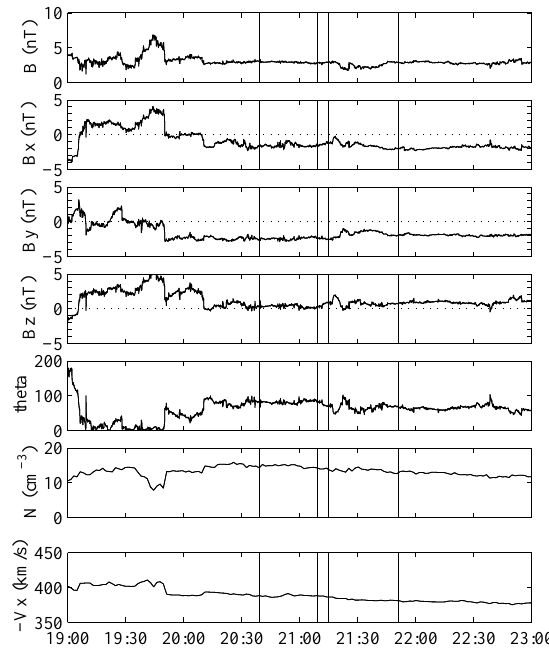
Fig. 4. Unshifted solar wind data in GSE-coordinates from WIND MFI (time resolution 3s) and SWE (time resolution 92s). The ver- tical lines show the times of the substorm onset and subsequent in- tensifications as determined from ground-based magnetic field data. The propagation time from WIND to the magnetopause was roughly